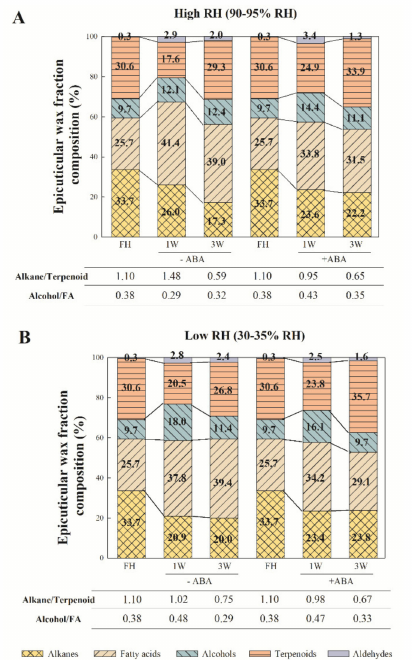
Figure 2. Effect of ABA and water stress on the proportion of epicuticular wax fractions in Pinalate fruit. The effect of ABA (1 mM) treatment on the percentage (%) of epicuticular wax fractions by 1 and 3 weeks (W) of Pinalate fruit storage at 20 ◦ C was evaluated together with the influence of the ( A ) high (90–95%) or ( B ) low (30–35%) RH conditions. FH: Freshly harvested fruit. The values on the bars indicate the percentage of each fraction. The alkane/terpenoid and alcohol/FA ratios are indicated per condition. The same legend is used for panels ( A , B